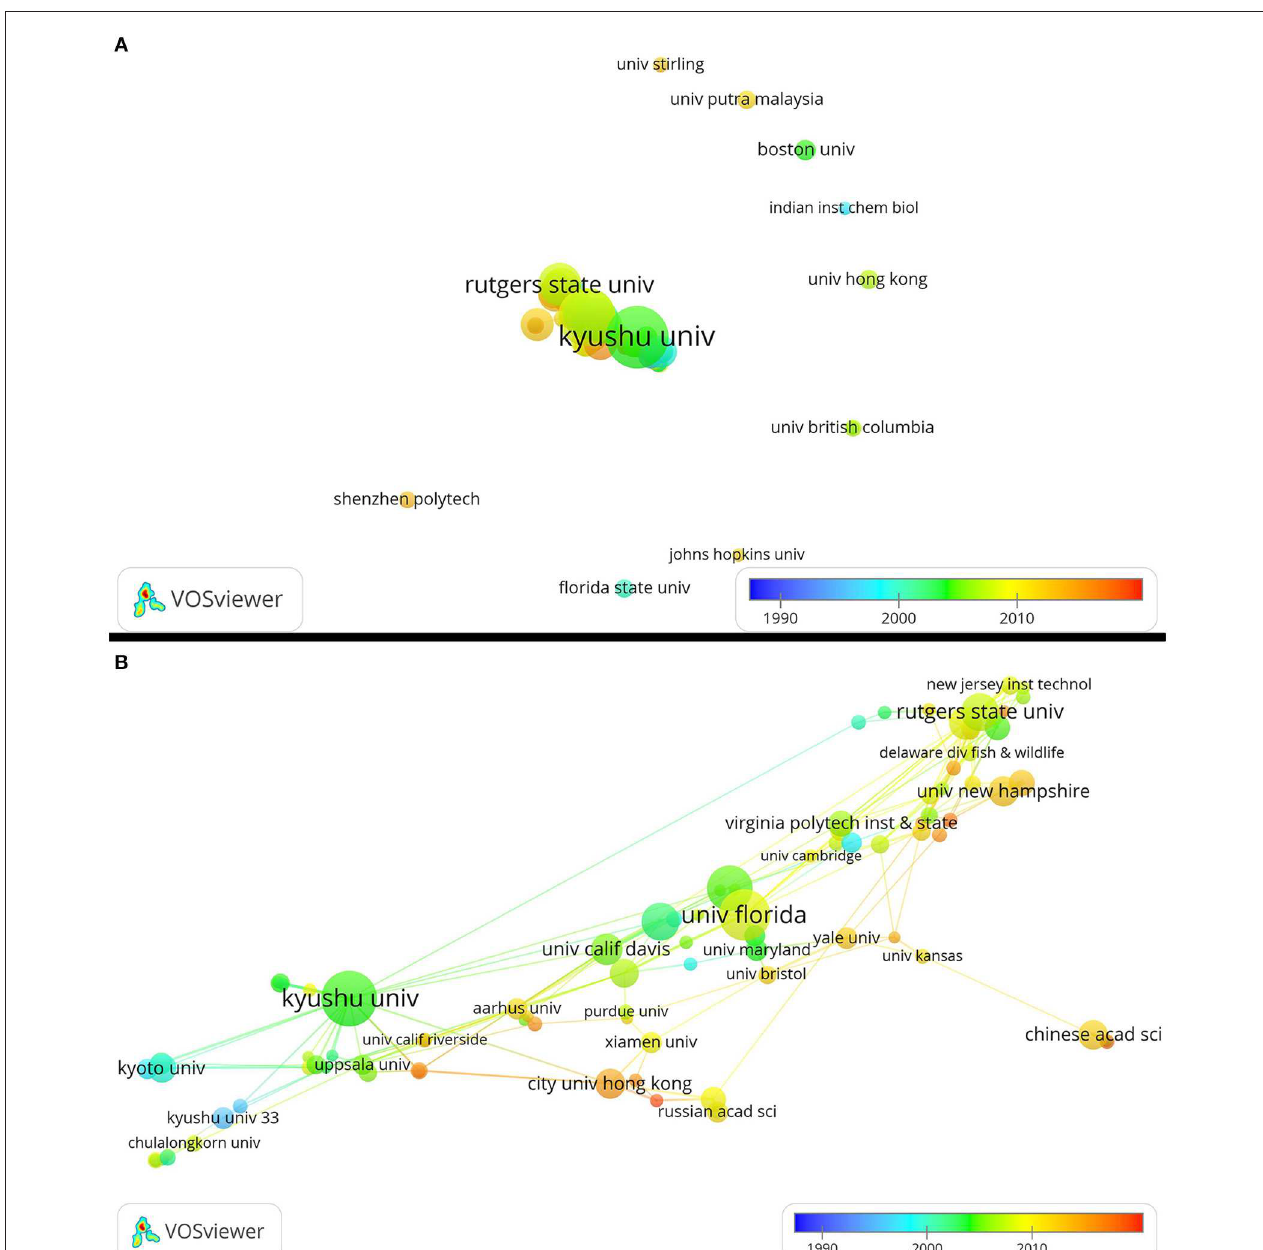
FIGURE 3 | Network showing cooperation among organizations. (B) Is the zoomed-in result from (A) . Large dots indicate that organizations have a high number of publications. The color of each dot represents when the publication is released. Thick lines indicate cooperation among numerous